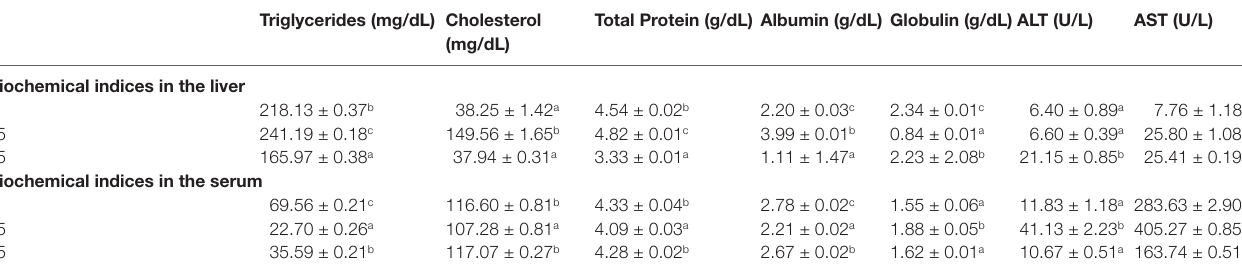
TABLE 6 | Biochemical indices in the liver and serum of Orange chromide reared in different salinities. Triglycerides (mg/dL) Cholesterol (mg/dL)